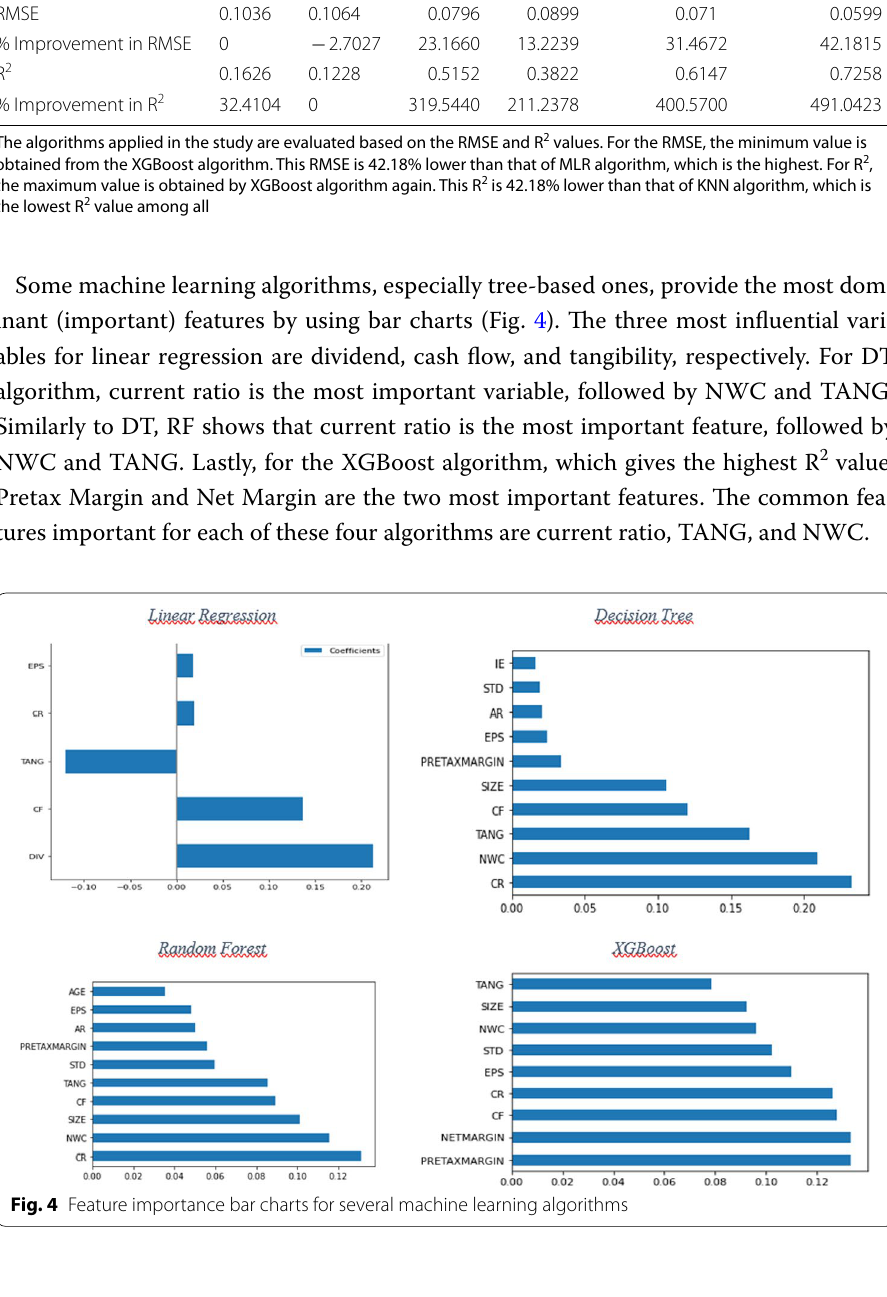
Table 13 Performance metrics comparison for the algorithms